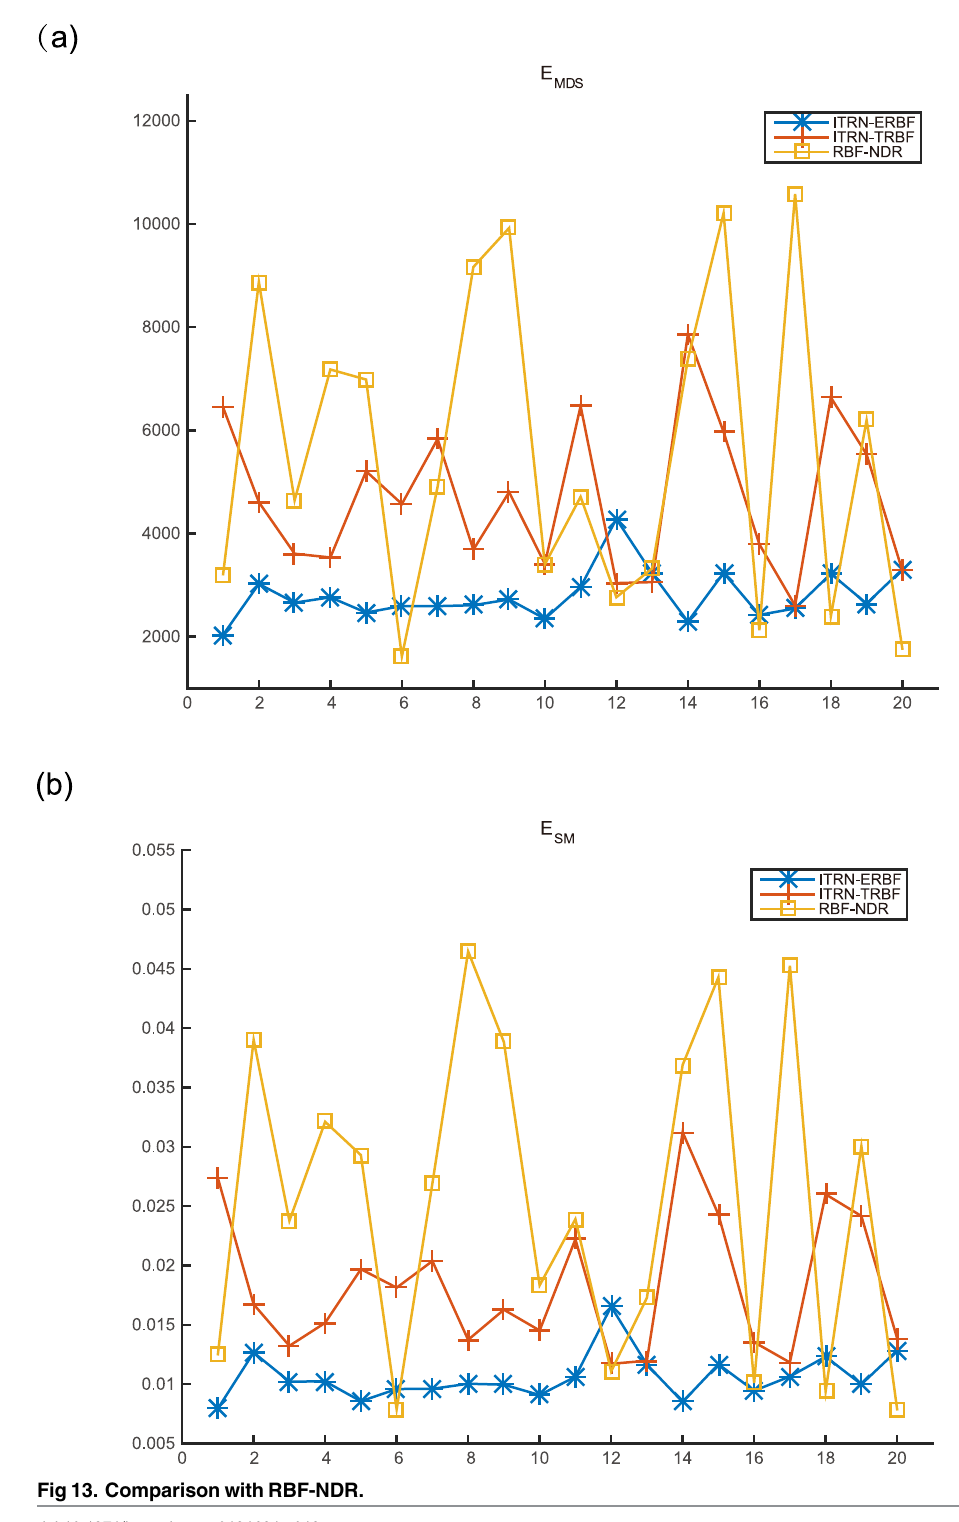
Fig 13. Comparison with RBF-NDR.